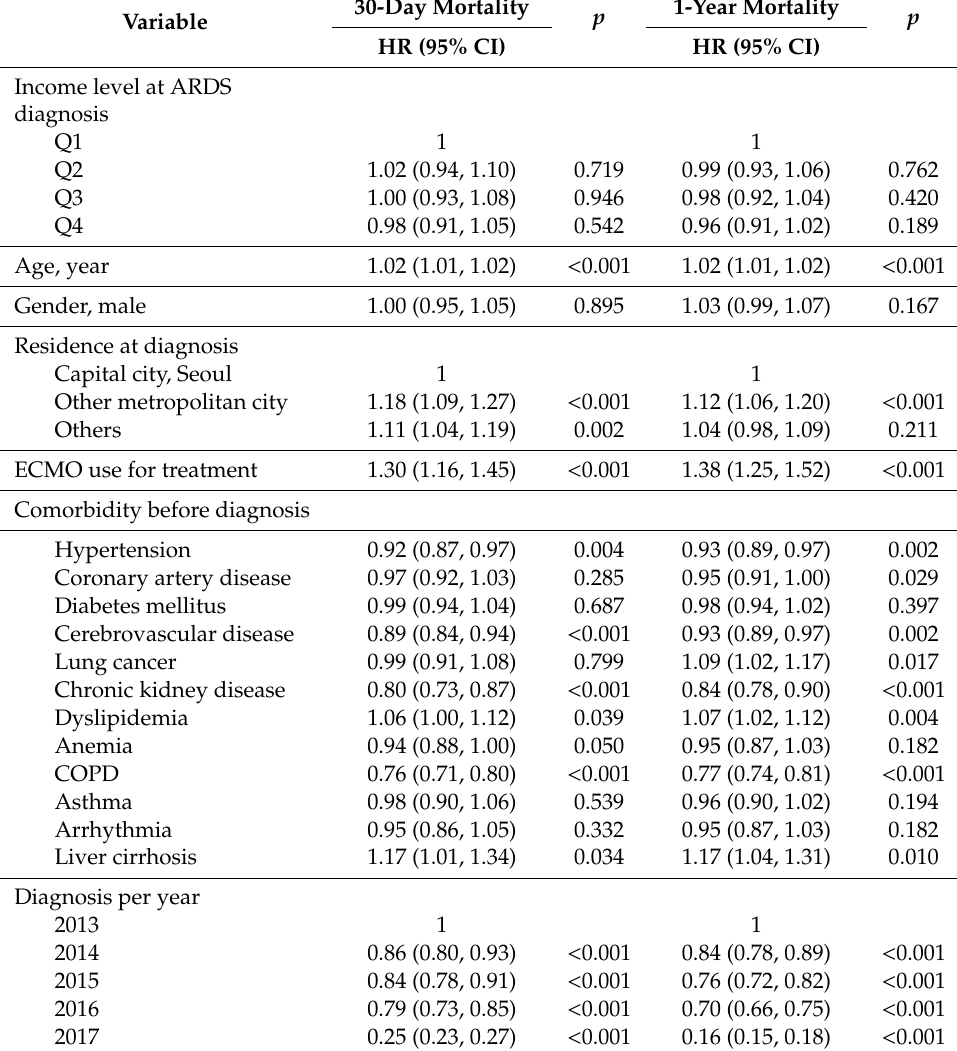
Table 2. Multivariable Cox regression model for 30-day and 1-year mortality according to income